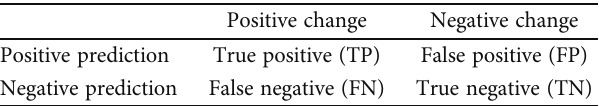
Table 5: The confusion matrix for price movement prediction of the CSI300